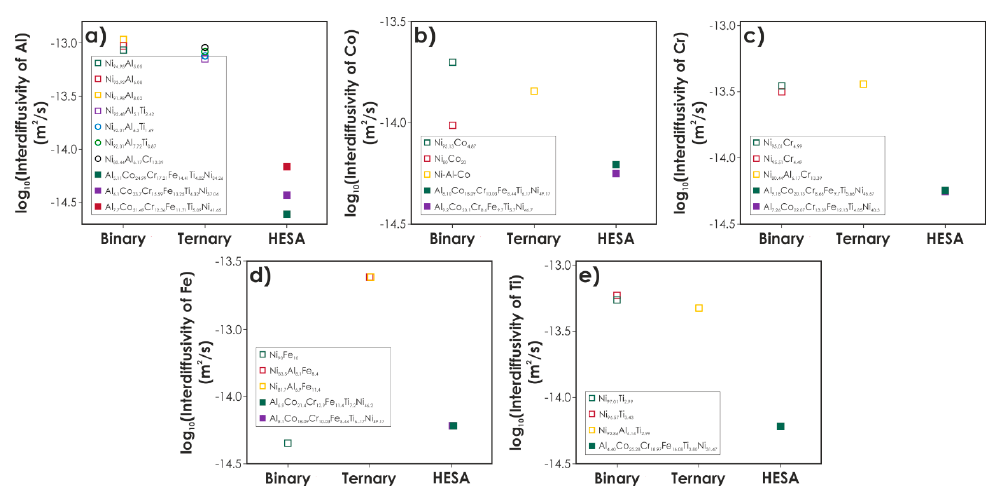
Figure 16. Comparisons of the main interdi ff usivities for the Al-Co-Cr-Fe-Ni-Ti system with the literature data in the other FCC alloys when Ni was taken as the solvent (after [38]). Reprinted from Journal of Alloys and Compounds 791 (2019), On di ff usion behaviors in face centered cubic phase of Al-Co-Cr-Fe-Ni-Ti high-entropy superalloys, 255–264, Copyright 2019, with permission from